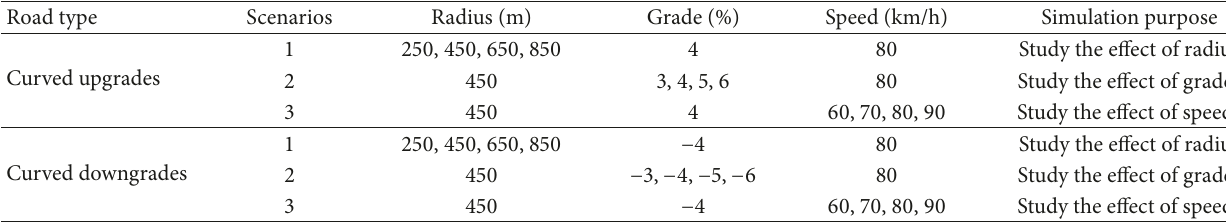
Table 2: Design of controlled variable simulation scenarios.